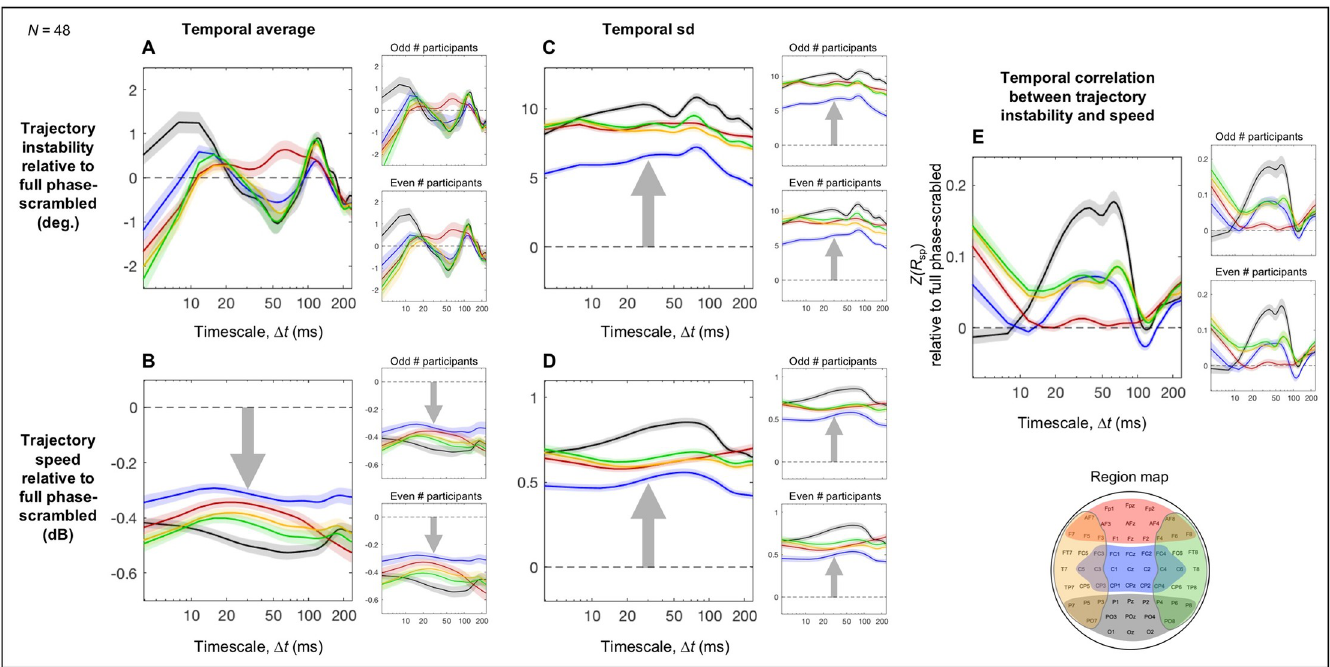
Fig 4. The phase-relation dependent aspects of trajectory instability and speed and their temporal correlation as a function of timescale Δ t relative to the corresponding full phase-scrambled controls. For each plot, the reliability of the data patterns is demonstrated by the accompanying plots on the right showing virtually identical patterns obtained from the odd and even numbered participants. A. Time-averaged trajectory instability as a function of Δ t (real data minus the corresponding phase-scrambled controls). B. Time-averaged trajectory speed as a function of Δ t (real data vs. the corresponding phase-scrambled controls in dB). C. The temporal variability (measured as standard deviation) in trajectory instability as a function of Δ t (real data minus the corresponding phase-scrambled controls). D. The temporal variability (measured as standard deviation) in trajectory speed as a function of Δ t (real data vs. the corresponding phase-scrambled controls in dB). E. The temporal correlation between trajectory instability and speed as a function of Δ t (real data minus the corresponding phase-scrambled controls in z -transformed Spearman r). In all panels, the data for the posterior, central, anterior, left-lateral, and right-lateral regions are shown in black, blue, red, orange, and green curves, respectively (see the region map). The shaded areas represent ± 1 standard error of the